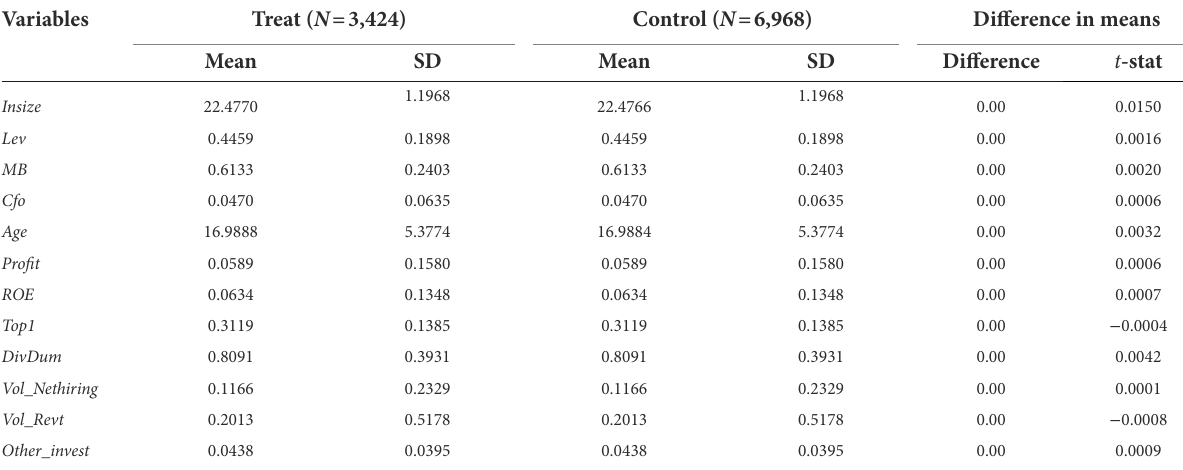
Panel B: Regression results for postdoctoral workstation and specific types of LIE